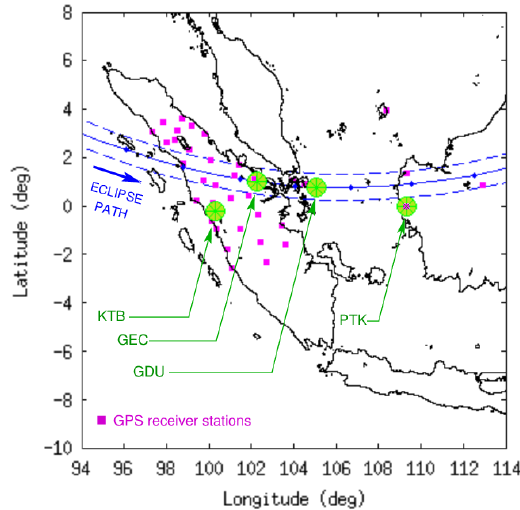
Figure 8. Geographical map showing a set of discrete check- points for the TEC and (cid:49) TEC time series analysis shown in Figs. 9 and 10. These fixed checkpoints are over Kototabang (KTB; 0.20 ◦ S, 100.32 ◦ E), the point of greatest eclipse (GEC; 1.01 ◦ N, 102.25 ◦ E), the point of greatest annularity duration (GDU; 0.78 ◦ N, 105.08 ◦ E), and Pontianak (PTK; 0.04 ◦ S, 109.35 ◦ E). The path of the annular solar eclipse is shown on the map as a blue curve and lo- cations of ground-based GPS receiver stations as magenta